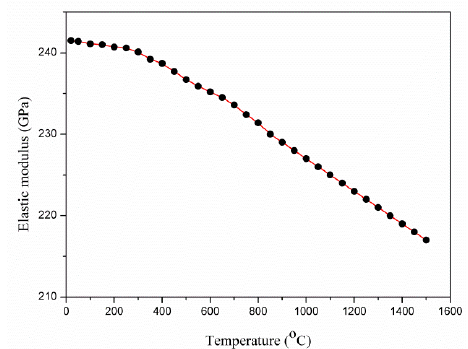
Fig. 8 Elastic modulus of YAG transparent ceramic as a function of temperature from room temperature (26 ℃ ) to 1600 ℃ .